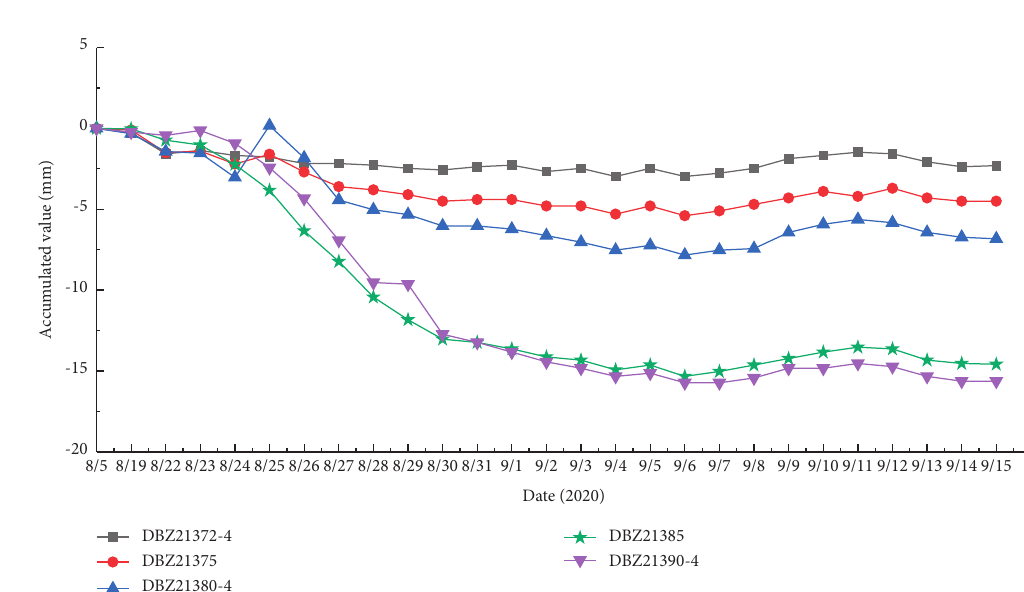
Figure 13: Curve of ground surface vertical